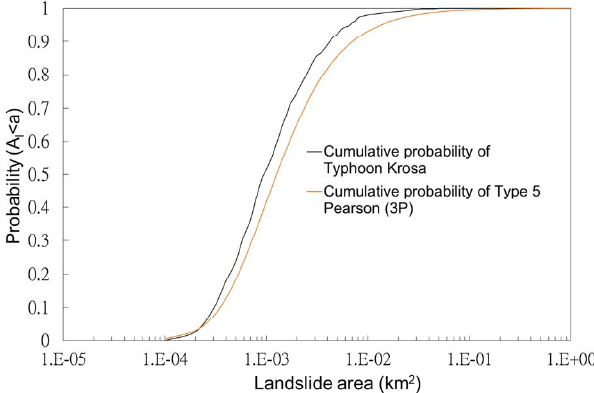
Fig. 10. Cumulative percentage of landslide area for the landslides caused by Typhoon Krosa in 2007. 4